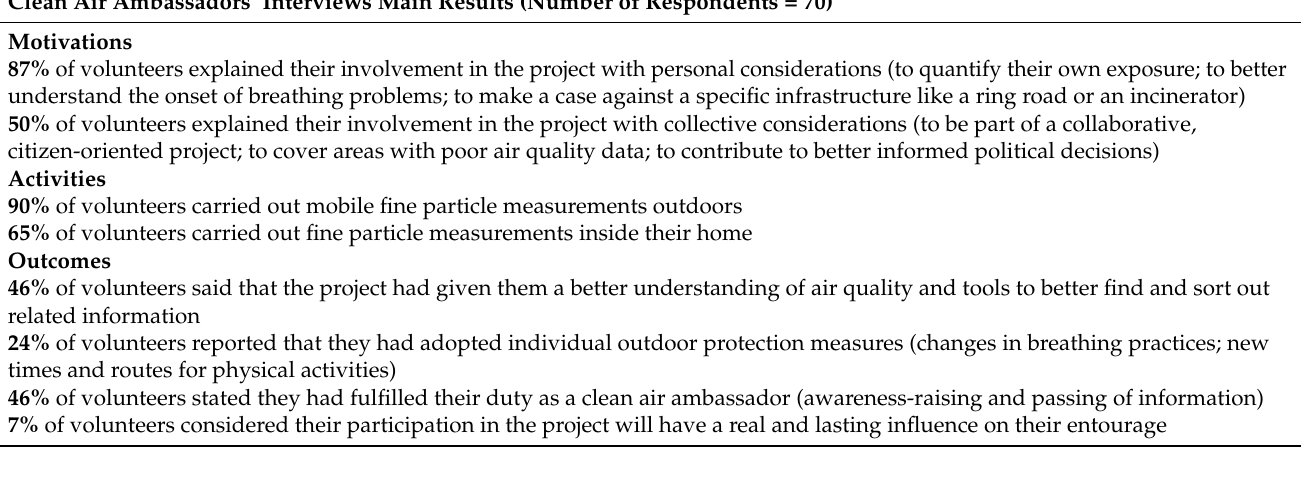
Table 2. Clean air ambassadors’ key interview